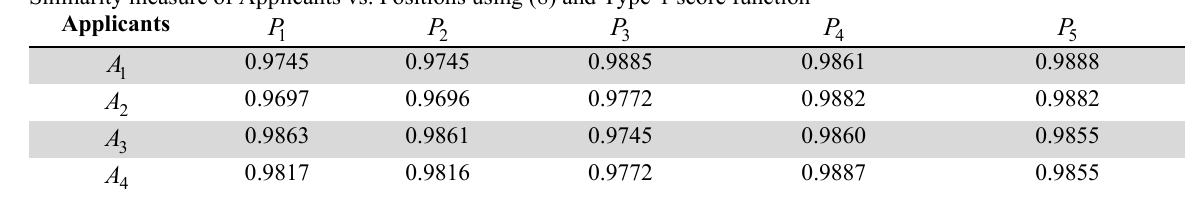
Similarity measure of Applicants vs. Positions using (8) and Type-1 score function